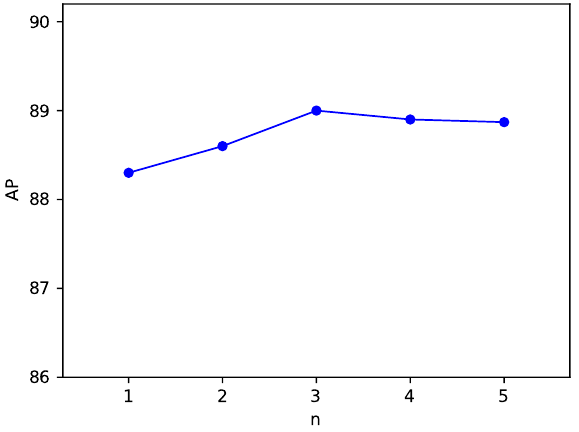
Figure 10. AP versus the number of SE